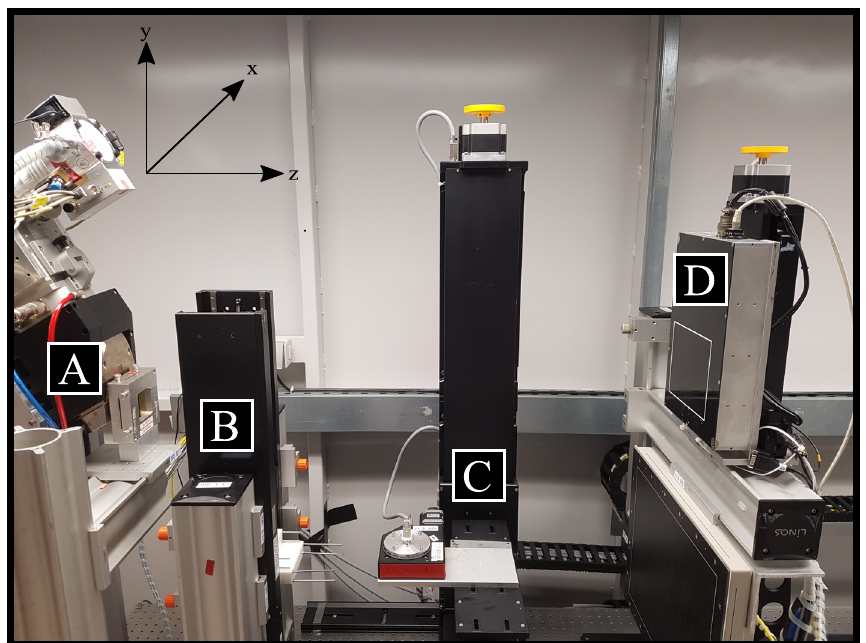
Fig 1. Experimental setup. Photography of the spectral micro-CT set-up: (A) micro-focus x-ray source with beam collimator, (B) linear-stages with calibration phantoms to automatically calibrate the model parameters, (C) mounting and positioning devices for the sample and adjustment of magnification and voxel-size, (D) photon-counting detector.